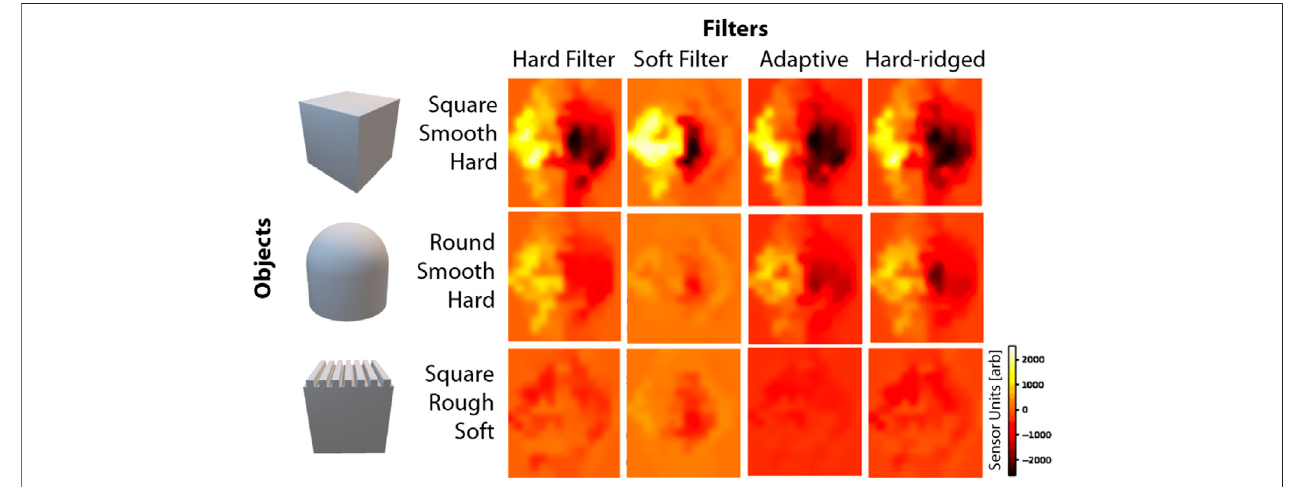
FIGURE 5 | Raw tactile sensor activation after 2.5 s from the beginning of the touch experiment, when touching three objects with four different fi lter shapes. Brighter colors correspond to higher sensor values.